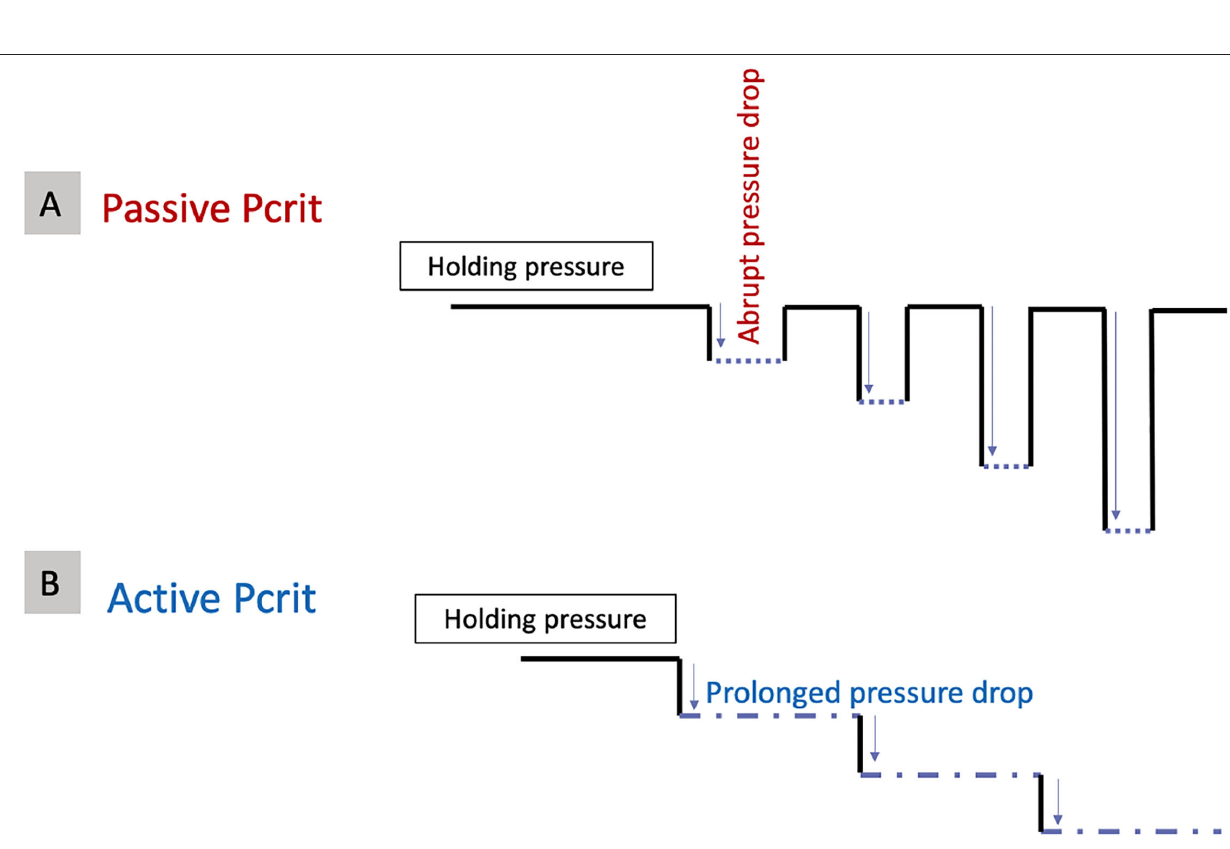
Frontiers in Neurology | www.frontiersin.org